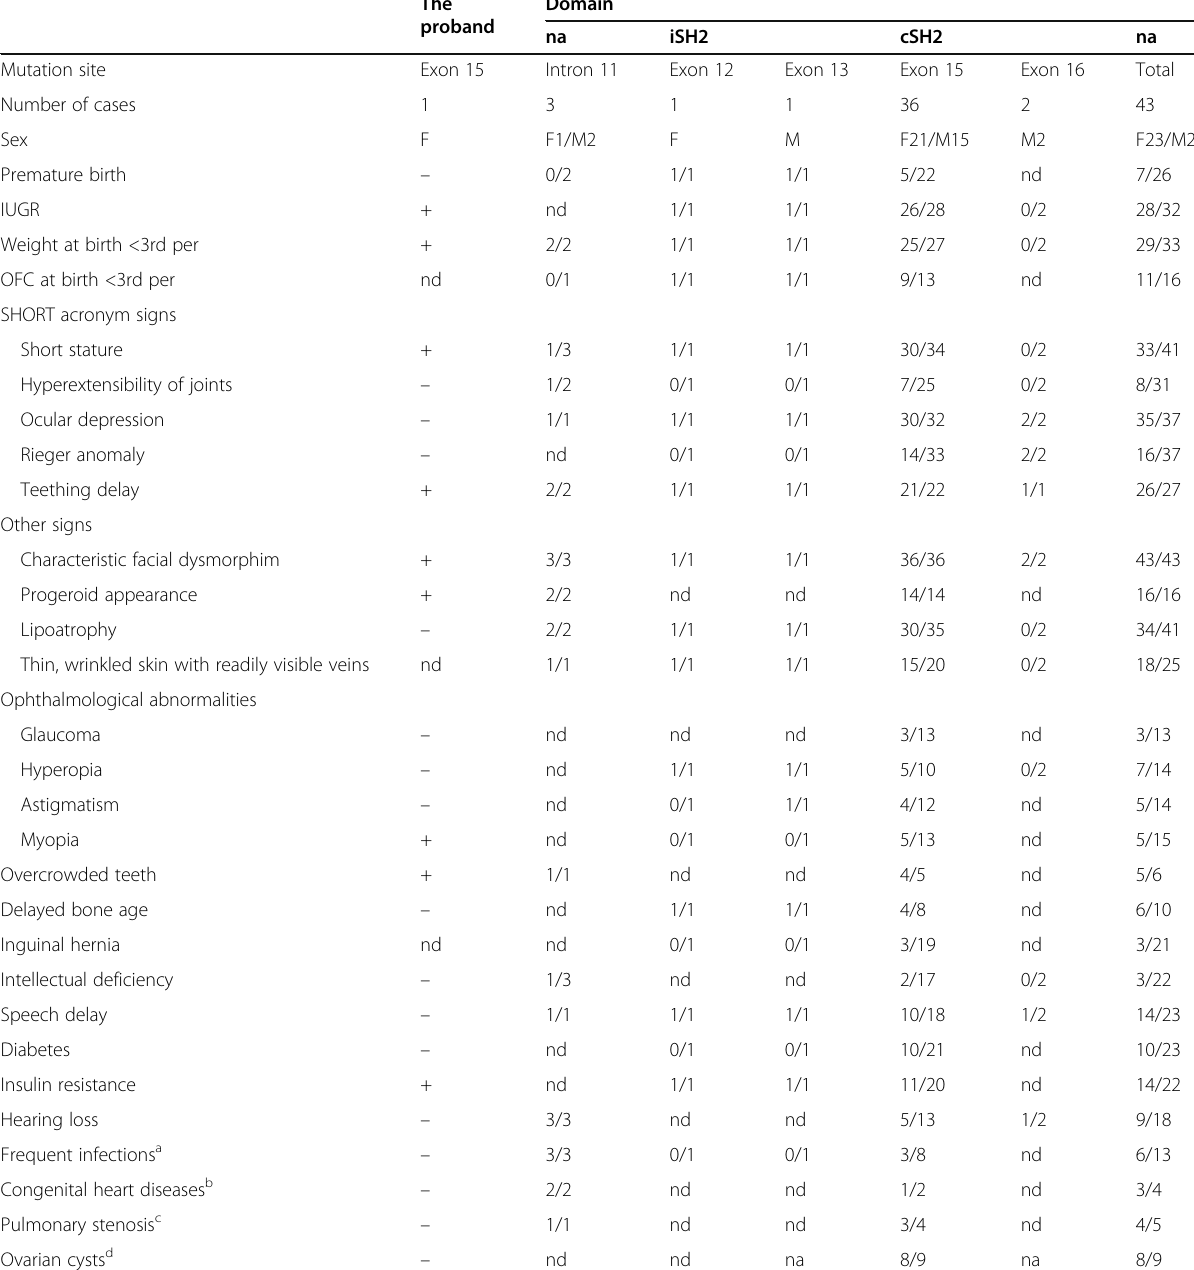
Table 2 Clinical Features of the patient and reported SHORT patients with Mutations in PIK3R1